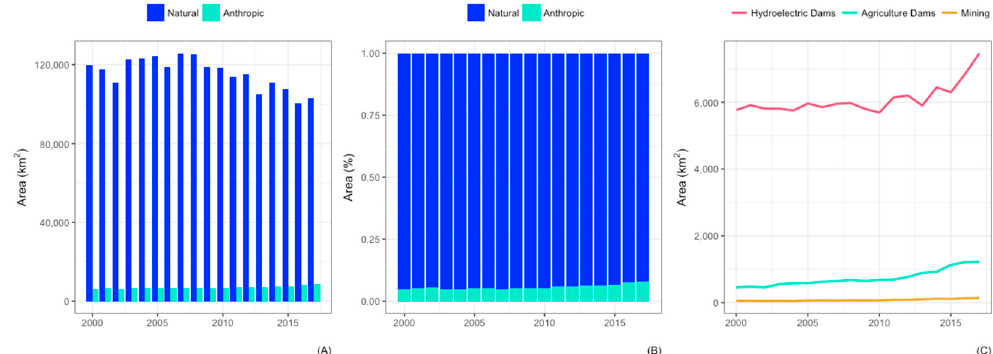
Figure 8. Absolute ( A ) and relative ( B ) surface water types showing a decrease in Natural water bodies, and an increase in Anthropic ones. Hydroelectric Dams showed an increase in surface water after 2010, and Agriculture Dams steady growth since 2000 ( C ).